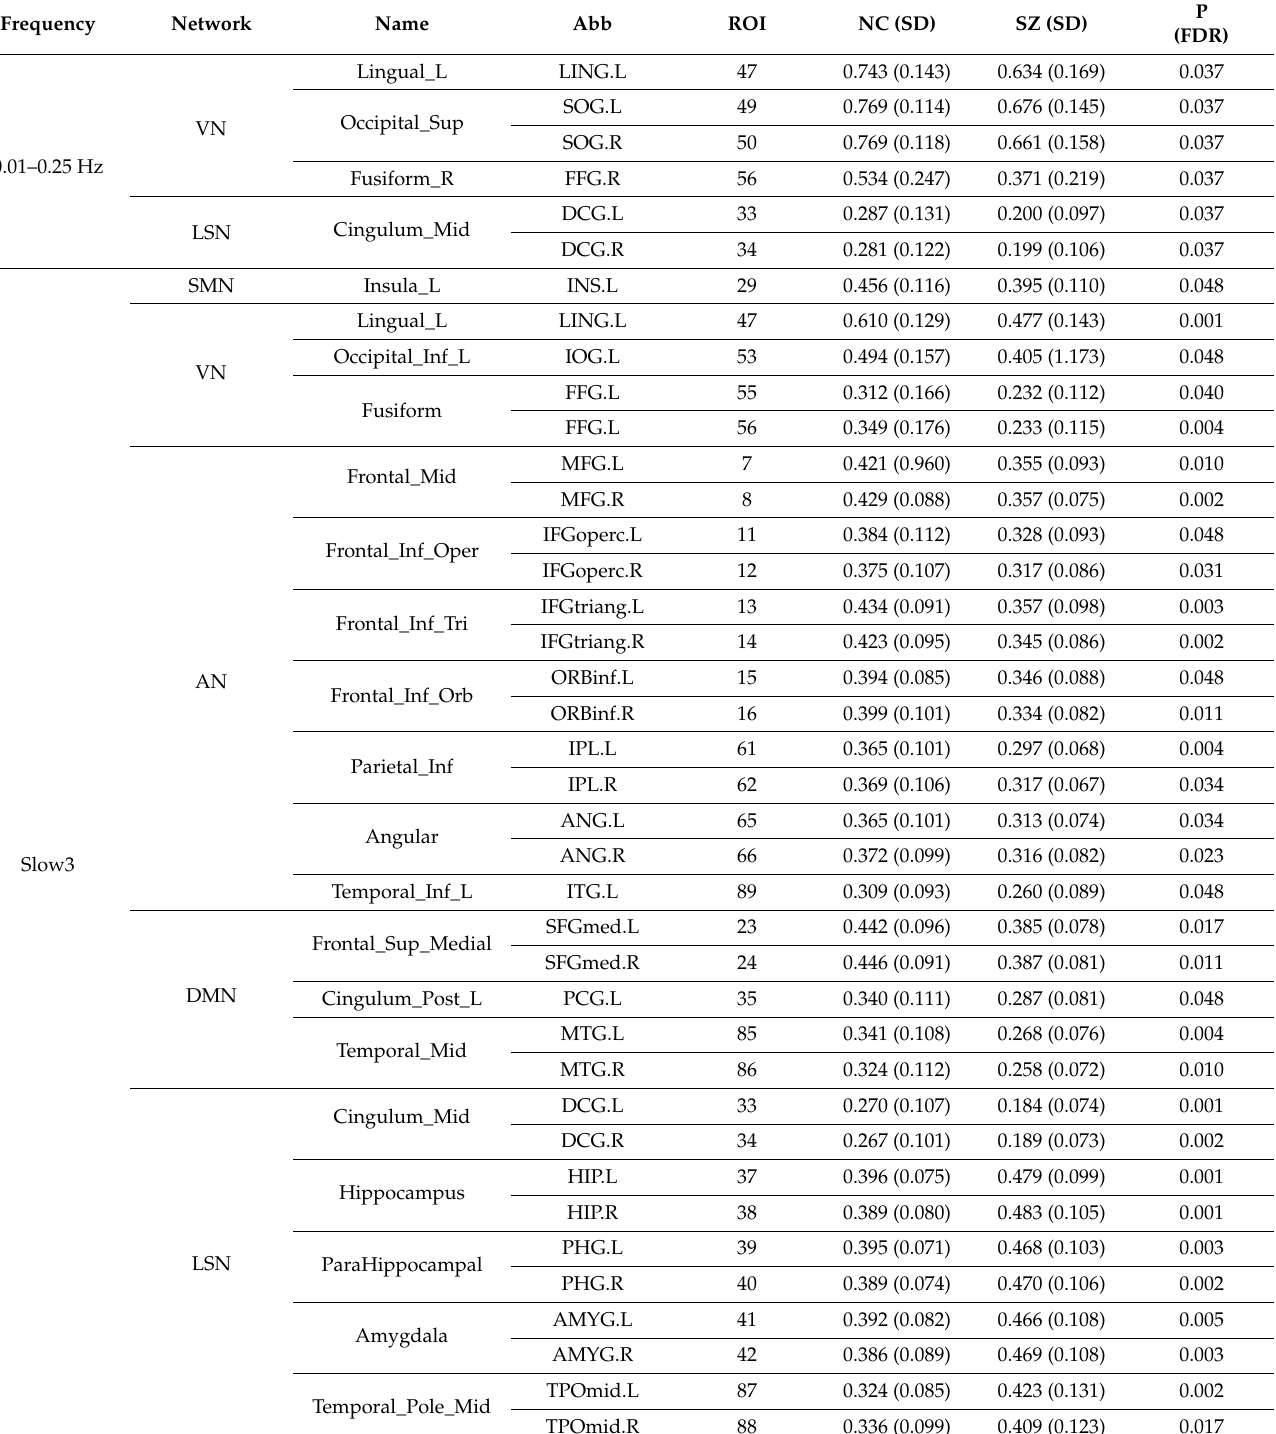
Table 7. Brain map of regions with significant differences on recruitment in full